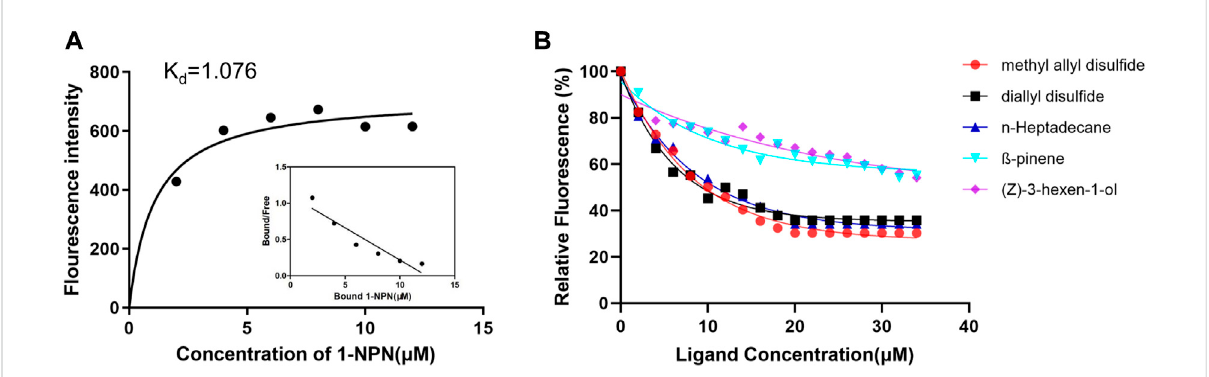
FIGURE 2 Binding curves for 1-NPN and Scatchard plots of recombinant BodoCSP4 (A) and fl uorescence competitive binding curves of the recombinant protein BodoCSP4 with fi ve ligands (B)